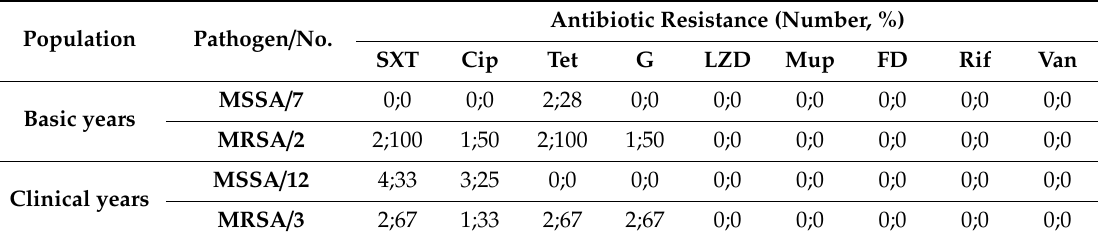
Table 2. Antibiotic resistance pattern of MSSA and MRSA isolates from basic and clinical year medical